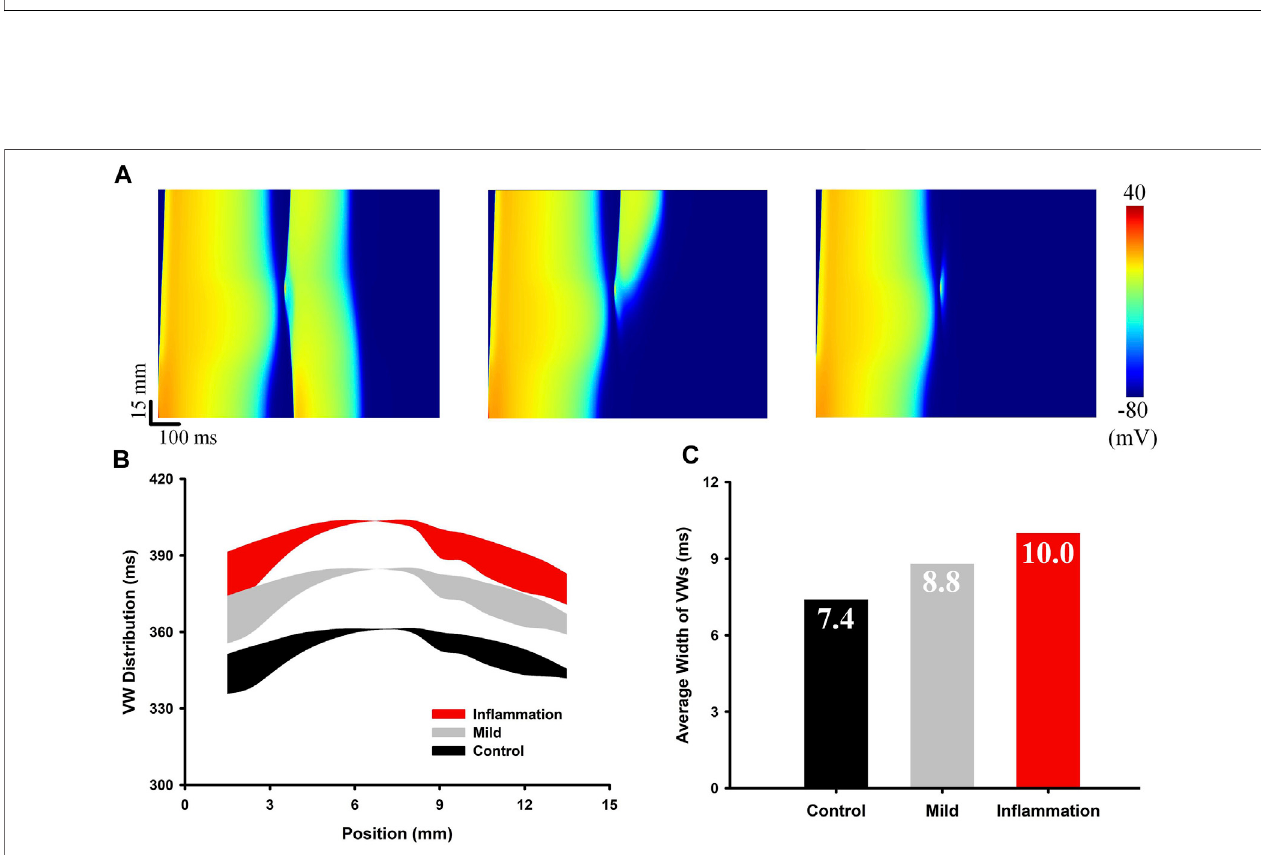
FIGURE 4 | Measurement of the VW in the 1-D strand model under normal, mild in fl ammatory, and extreme in fl ammatory conditions. (A) The three subplots from left to right show the bidirectional conduction, the unidirectional conduction block, and the bidirectional conduction block. (B) Distributions of VWs across the strand. Black and red belts represent the control and in fl ammatory conditions, respectively. (C) Comparison of the average width of the VWs in the three groups.